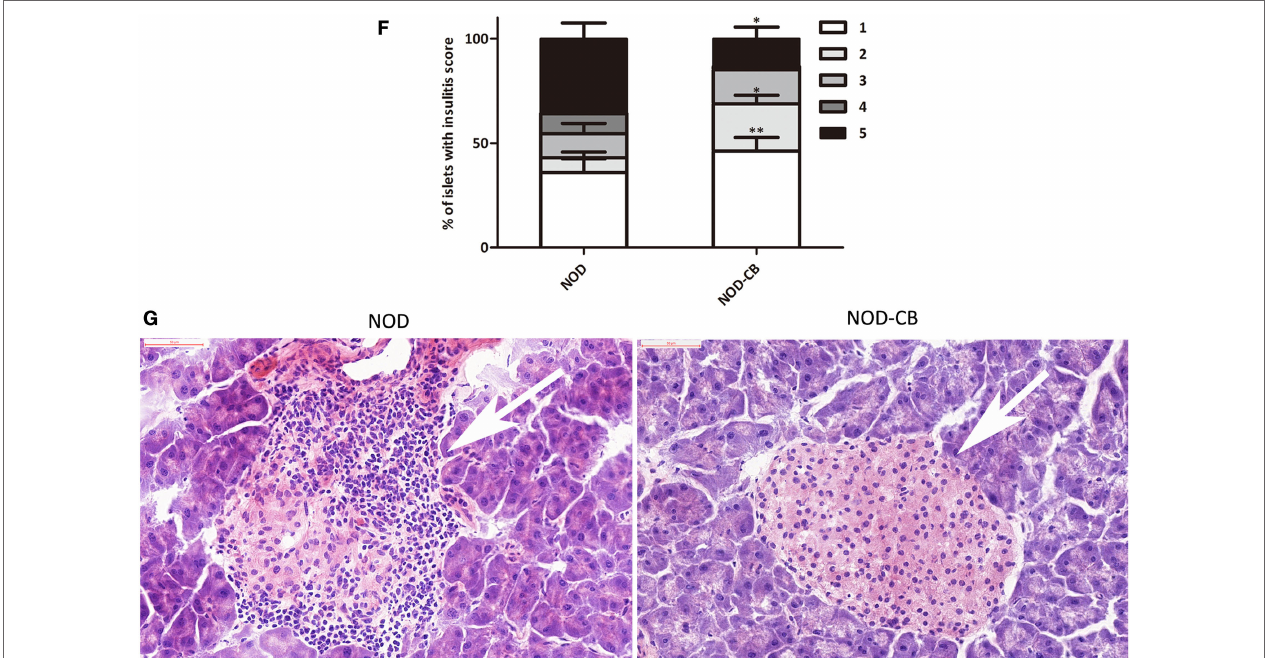
FigUre 1 | CB0313.1 delays the onset and reduces the incidence of diabetes. (a) To evaluate the effect of CB0313.1 on the onset of type 1 diabetes, NOD mice were randomly assigned to two groups to receive CB0313.1 or equal volumes of sterile water by gavage from 3 to 45 weeks of age. NaB was used as positive control. Mice were monitored for the appearance of clinical signs of diabetes and euthanized at disease occurrence for immune cell detection by flow cytometry. Experiment was carried up to 45 weeks of age and all remaining non-diabetic mice from all groups were euthanized for the detection of immune cells by flow cytometry. (B) Delayed onset and reduced incidence of diabetes in NOD-CB mice. Mice received CB0313.1, NaB, or sterile water treatment from 3 weeks of age with fasting glucose monitoring. Mice were diagnosed as diabetic and euthanized when blood glucose levels exceeded 11.1 mmol/L on 2 consecutive days along with polyuria. (c) Water intake. (D) Body weight. (e) Diet intake. (F) Insulitis score for NOD-CB and NOD control mice at 13 weeks of age. Percentage of islets with a given score at 13 weeks of age in NOD-CB ( n = 23) and NOD control ( n = 23) mice. 1 = white, no infiltration; 2 = light gray, few mononuclear cells infiltrated; 3 = gray, peri-insulitis; 4 = dark gray, < 50% islet infiltration; 5 = black, > 50% islet infiltration. (g) Histological examination of pancreatic islet infiltration by immune cells in female NOD mice at 13 weeks of age. Analysis of variance followed by the indicated post hoc test was performed to determine the significance among the three groups. t -test was used for two independent groups. *, **, *** p < 0.05, p < 0.01, p < 0.001 vs NOD control